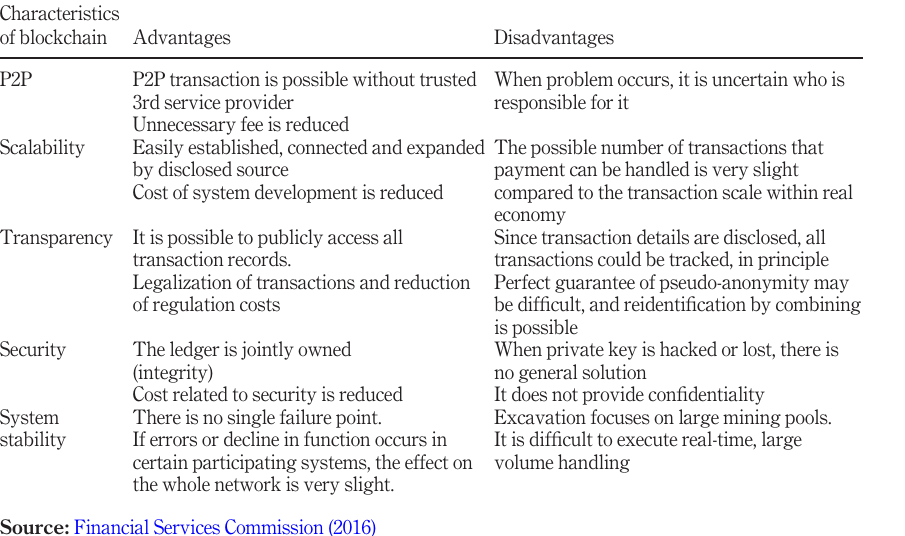
Table I. Characteristics